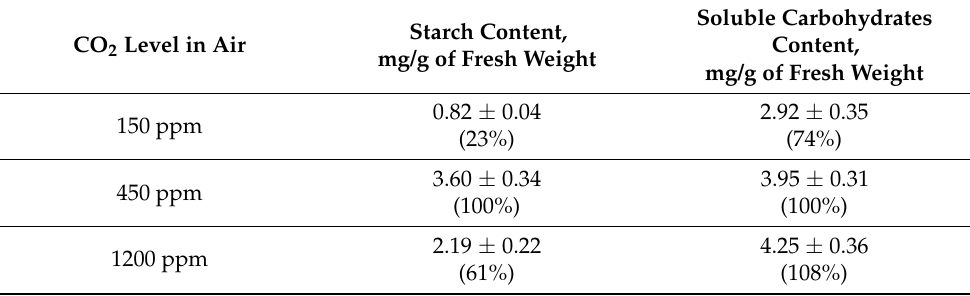
Table 1. The content of starch and soluble carbohydrates in Arabidopsis plant leaves after 16 days of acclimation to low (150 ppm), normal (450 ppm), and high (1200 ppm) CO 2 levels in the air. The table shows the data of a typical experiment. In the parentheses are given the data in % of those from control values, i.e., from data for plants grown at 450 ppm CO 2 . Soluble Carbohydrates Starch Content, CO 2 Level in Air mg/g of Fresh Weight